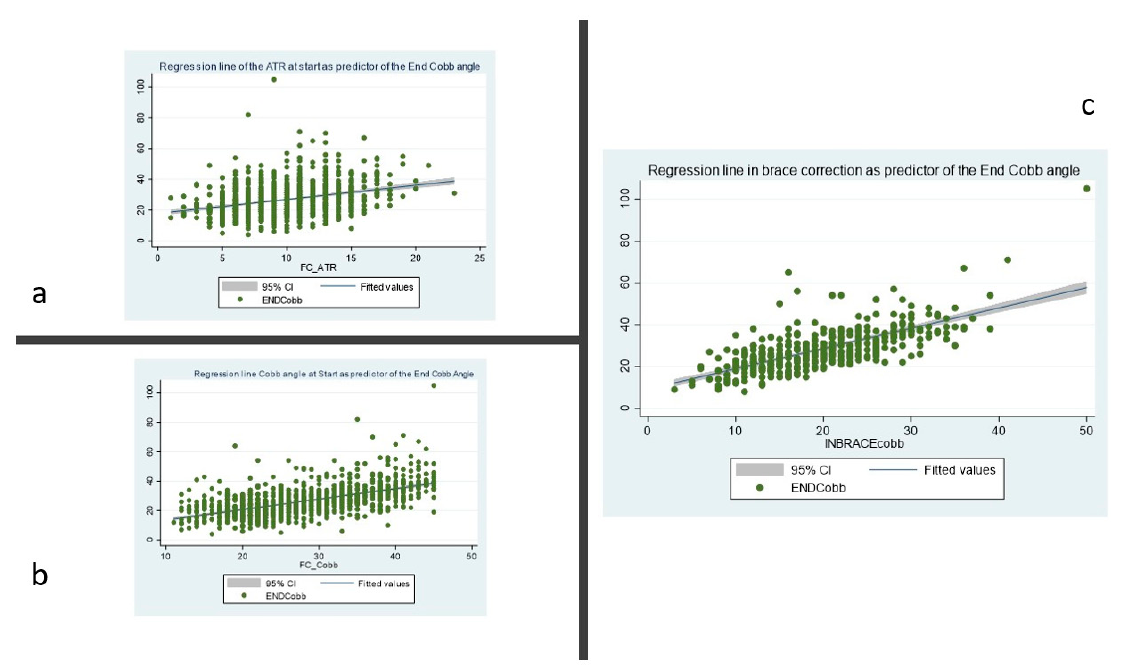
Figure 1. Two-way scatter plot of the regression line for the angle of trunk rotation (ATR) ( a ), Cobb Angle ( b ), and in-brace correction ( c ) at the start.